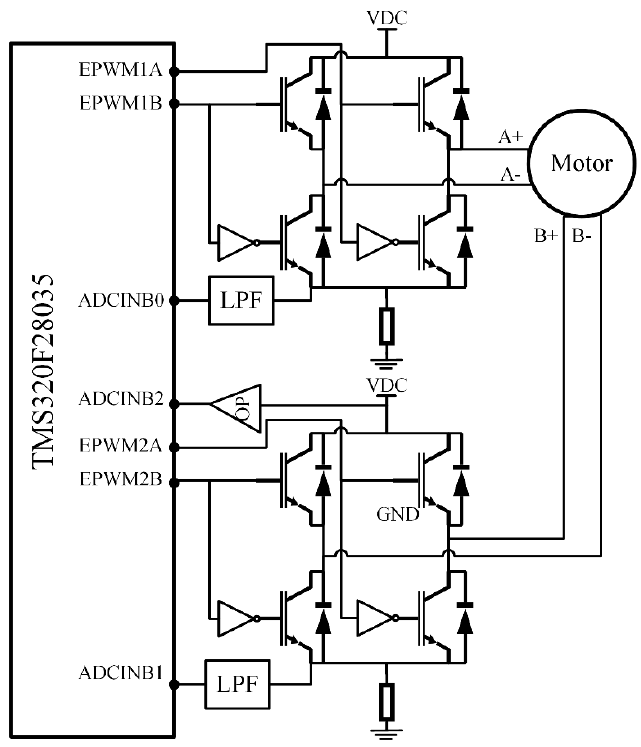
Figure 11. Overview of the stepper motor drive.